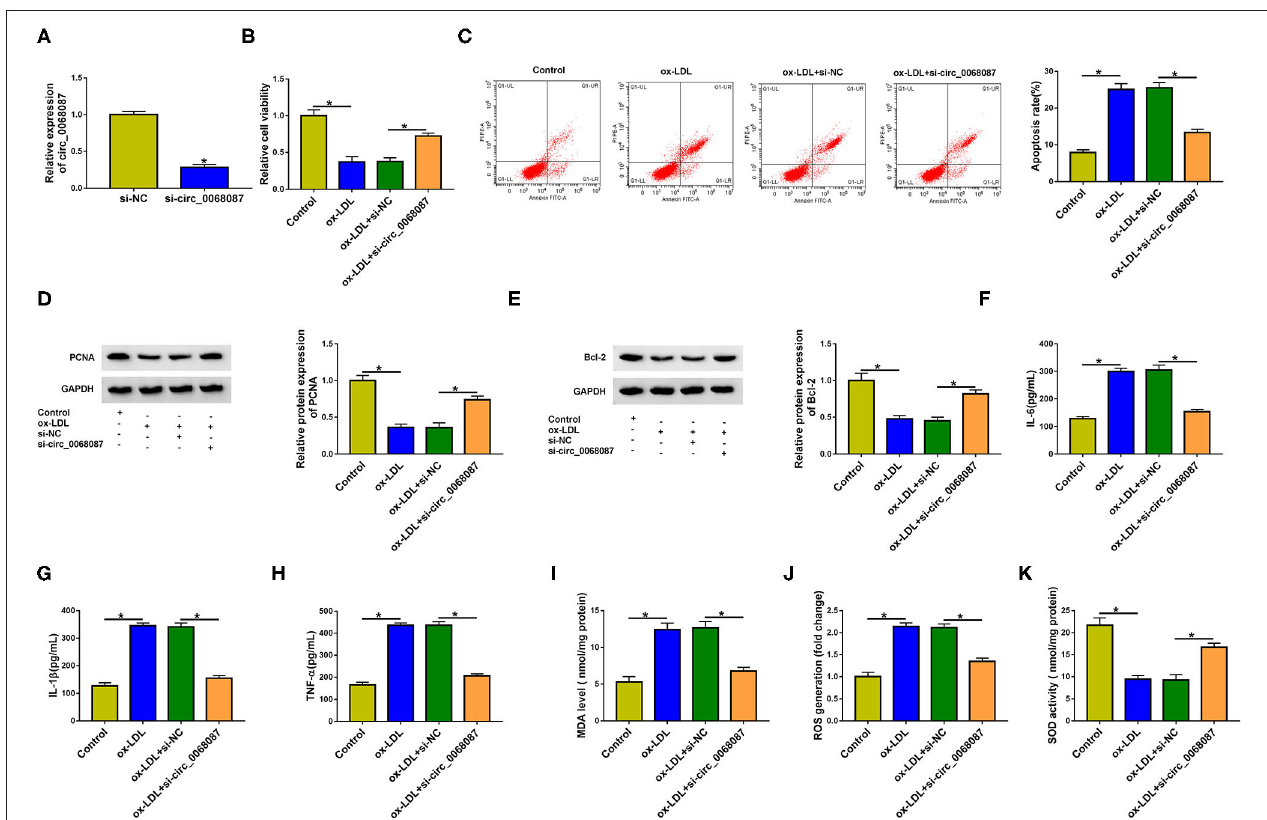
FIGURE 2 | Ox-LDL suppresses the viability and induces the apoptosis, inflammation, and oxidative stress of HUVECs partly through upregulating circ_0068087. (A) The interference efficiency of circ_0068087 siRNA (si-circ_0068087) in HUVECs was determined by RT-qPCR. This experiment was performed three times with three technical repetitions each time. An unpaired Student t -test was used to evaluate the differences. (B–K) HUVECs were divided into the following four groups: Control, ox-LDL, ox-LDL + si-NC, and ox-LDL + si-circ_0068087. One-way ANOVA followed by Tukey’s post hoc test was used to assess the differences. (B) Cell viability was analyzed by MTT assay. This experiment was performed three times with five technical repetitions each time. (C) The apoptosis rate of HUVECs was analyzed by flow cytometry. This experiment was performed three times with three technical repetitions each time. (D,E) Western blot assay was performed to measure the protein expression of PCNA and Bcl-2 in HUVECs. This experiment was performed three times. (F–H) The concentrations of pro-inflammatory cytokines (IL-6, IL-1 β , and TNF- α ) in the culture supernatant were measured by ELISA. This experiment was performed three times with three technical repetitions each time. (I–K) Three oxidative stress-related markers (MDA, ROS, and SOD) were determined by commercial kits. This experiment was performed three times with three technical repetitions each time. * P <